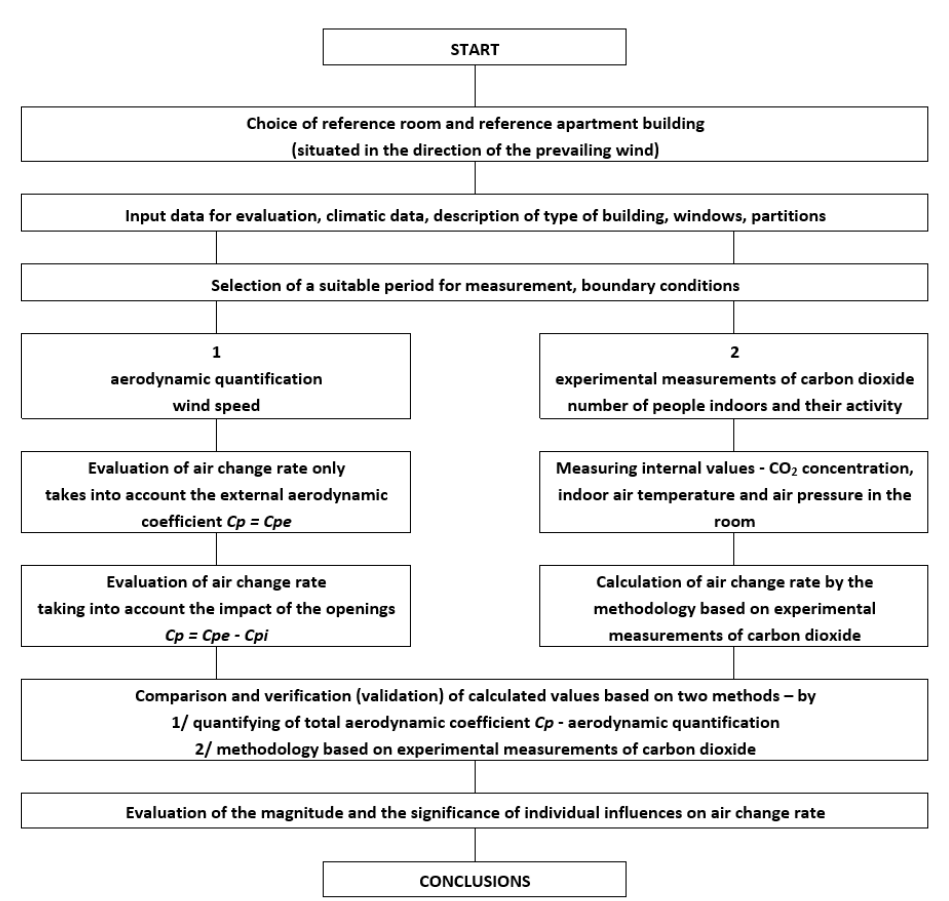
Figure 5. The subject, goal and methodology of the research: flowchart of research.